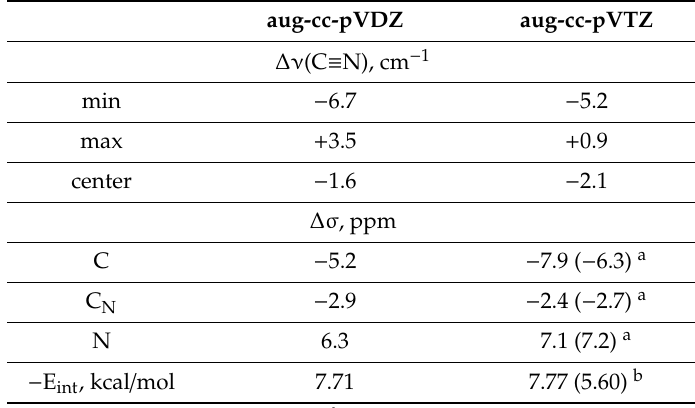
Table 6. Quantities calculated by two di ff erent basis sets for complex of H 3 C-C(CN) 3 with NH 3